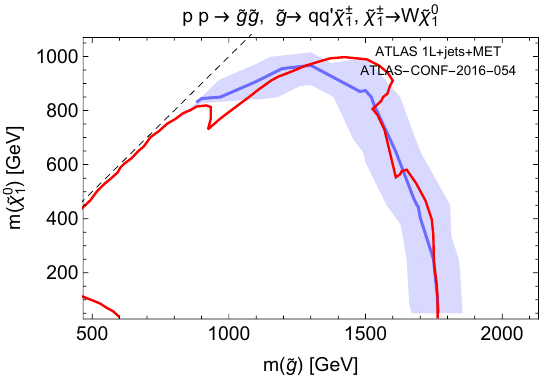
Figure 9 . Limits on supersymmetric simpli(cid:12)ed models from our recasted search of [53] (blue line) with 50% error on the number of events in the signal regions (blue shaded region), compared to the experimental results (red